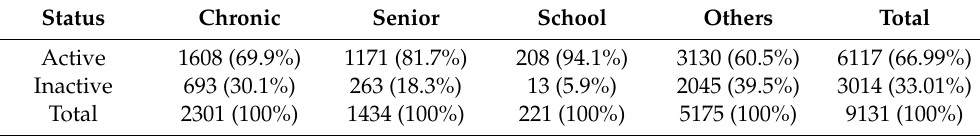
Table 2. Characteristics of M-Fund members by types of selected plan options.